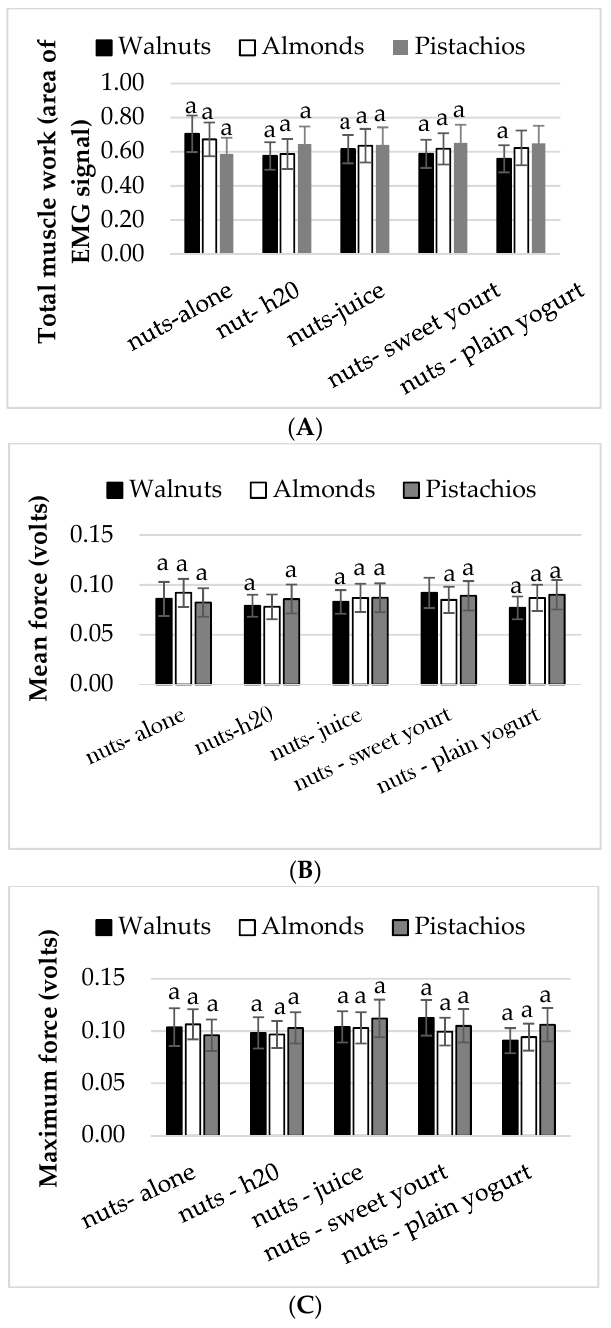
Figure 2. Mean ± S.E.M. ( A ) total muscle work (AREA), ( B ) mean bite force, and ( C ) maximum bite force obtained from EMG recordings. Conditions with the same lower case letters ( a ) represent no significant differences between conditions ( p > 0.05).